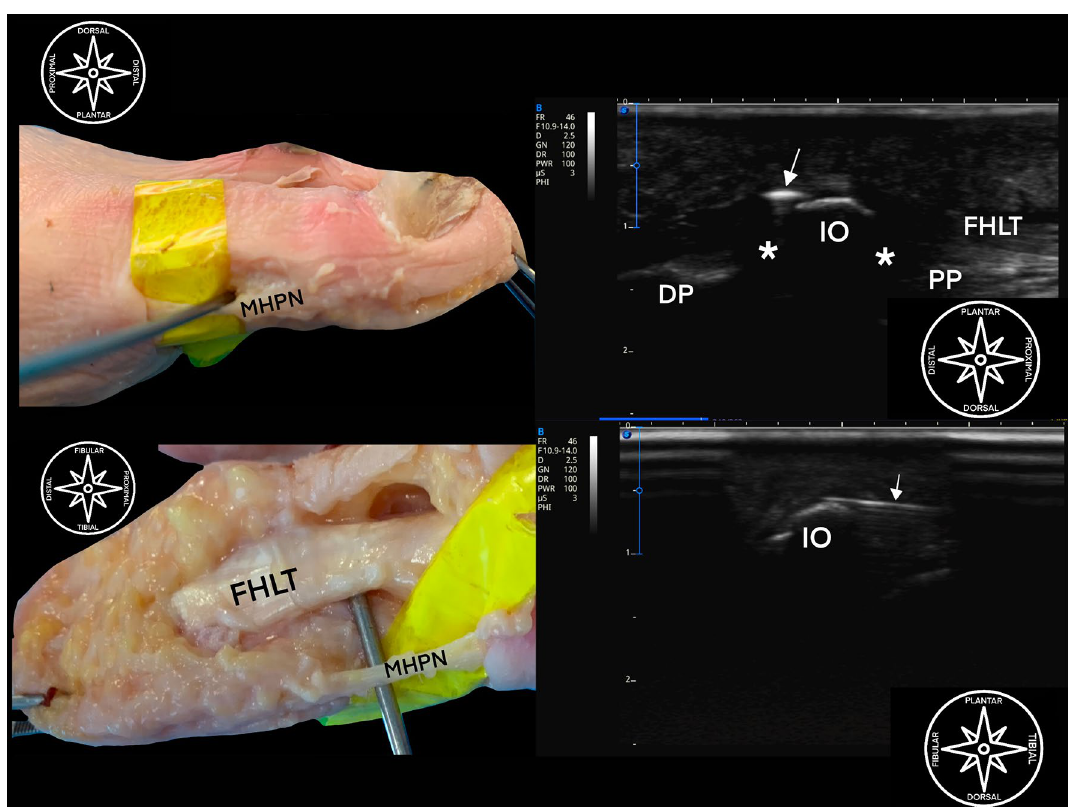
Figure 1. Ultrasound guided shaving of the interphalangeal joint ossicle of a left foot. ( A ) Dissection representation (tibial aspect) showing minimally invasive burr just dorsal to MHPN (medial plantar nerve). ( B ) Ultrasound guided shaving; PP proximal phalanx, DP distal phalanx, IO interphalangeal ossicle, asterisk * plantar plate, FHLT flexor hallucis longus tendon, white arrow showing burr (out of plane) between FHL and IO. ( C ) Dissection representation (plantar aspect) showing minimally invasive burr just dorsal to MHPN (medial plantar nerve); FHLT flexor hallucis longus tendon. ( D ) Ultrasound guided shaving; IO interphalangeal ossicle, white arrow showing burr (in-plane) between FHLT and